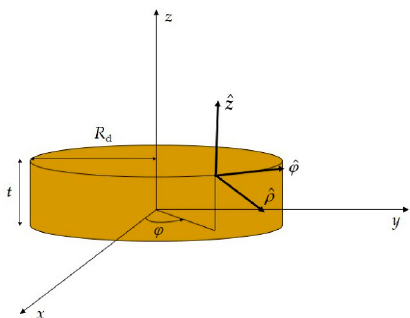
Figure 1. A sketch of the cylindrical dot hosting the Néel skyrmion with R d the dot radius and t the dot thickness. A cylindrical reference frame ( ρ , φ , z ) is also shown.